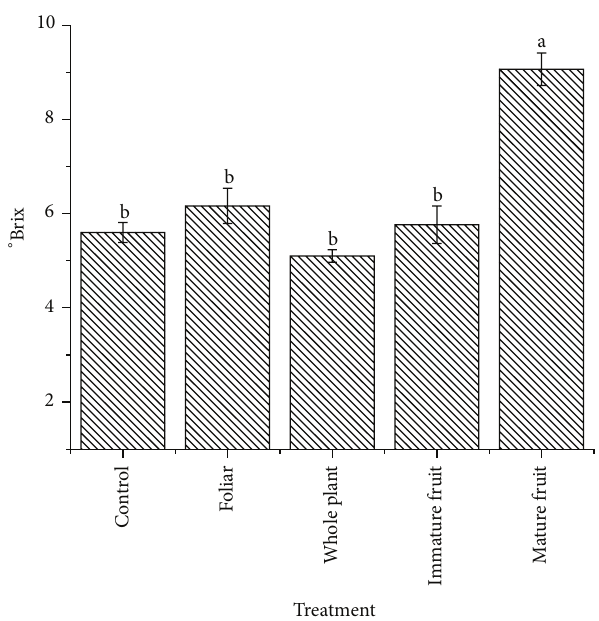
Figure 1: ∘ Brix of different MIF cocktails treatments. The same letter above the bars indicates no significant difference ( 𝑃 ≤ 0.05 ). Each bar is the mean of three replicates ± standard error.